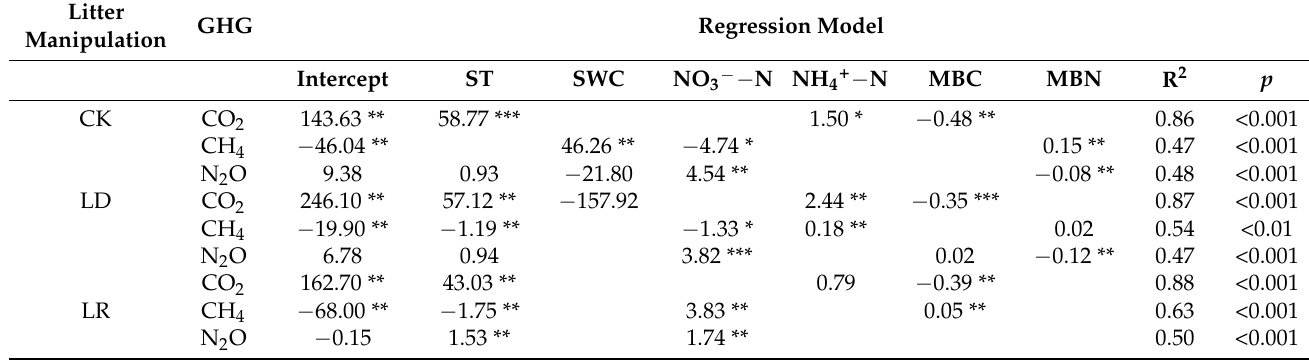
Table 3. The stepwise multiple linear regression model between the soil GHG fluxes and the soil factors in three litter manipulation treatments (* p < 0.05; ** p < 0.01; *** p < 0.001; numbers are the model coefficients). Litter manipulation treatment abbreviations: CK, unchanged litter input; LD, doubled litter; LR, litter